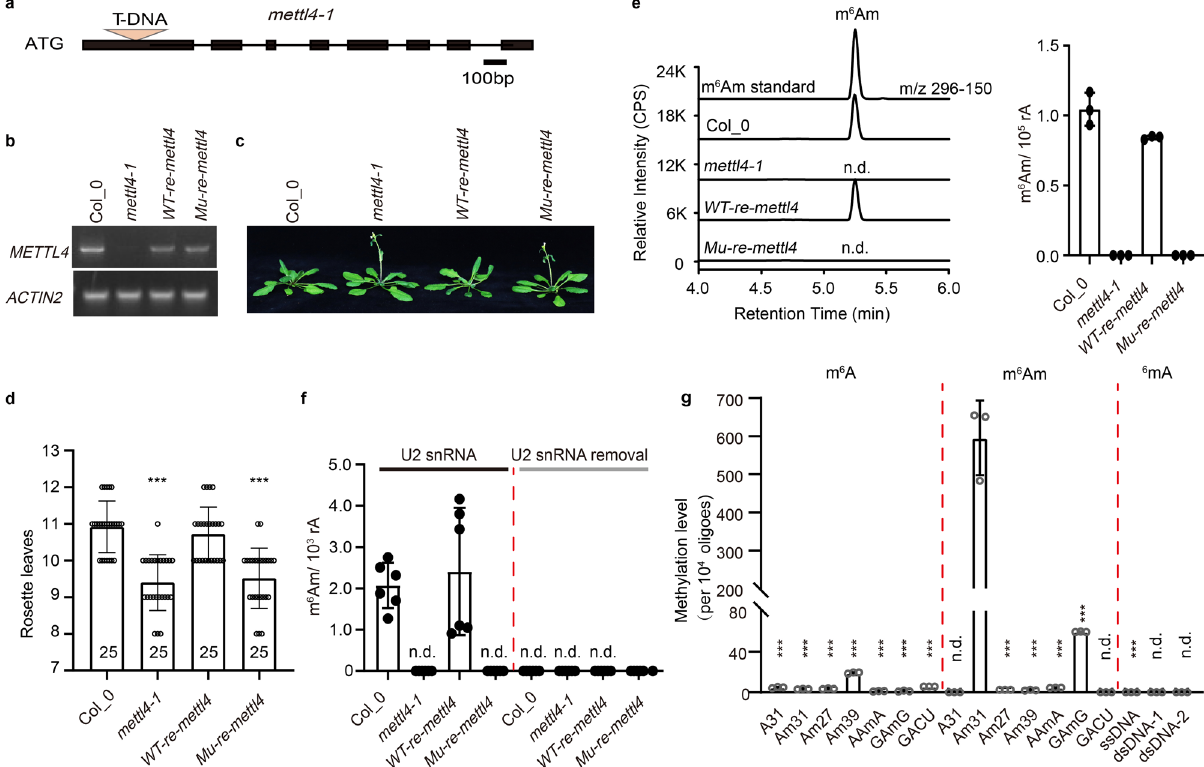
Fig. 1 | METTL4mediatessolely m 6 AmmethylationofU2snRNAin Arabidopsis thaliana . a The diagrammatic sketch of the T-DNA insertion site in the METTL4 gene. b RT-PCR validation of the full-length transcript of the METTL4 gene, the AtACTIN2 transcript acts as a control. c The phenotype of the Arabidopsis plants grown inlong-day (LD)condition (22°Cand 16-h-light/8-h-dark). d Statistics of the number of rosette leaves when fl ower bunds fi rst appeared, which correlates with fl owering time. And the number of the calculated plants were shown in the bar column. The APPA mutant was generated from conserved DPPW motif. Wild-type